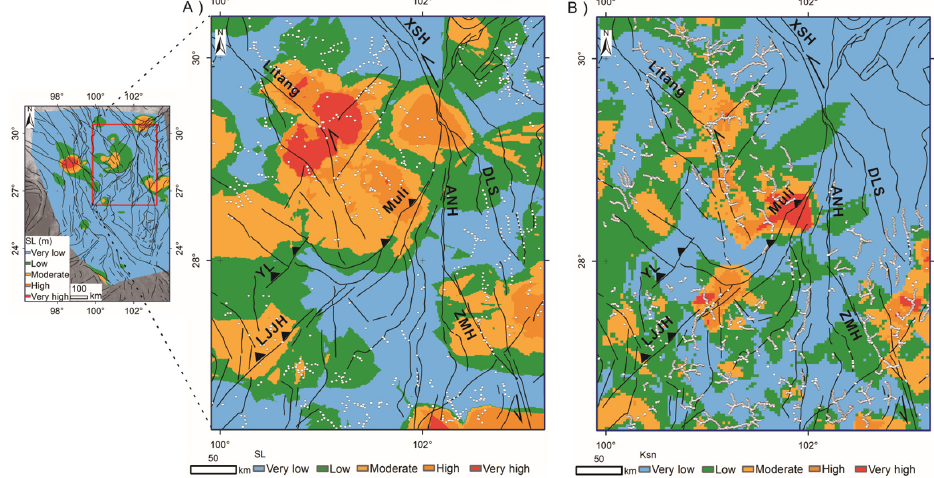
Figure 11. ( A ) Interpolation of SL points underlain by sandstone. The colors represent the following values: Blue—very low (44–181 m), green—low (181–288 m), yellow—moderate (288–407 m), orange—high (407–581 m), and red—very high (>581 m). ( B ) Interpolation of K sn points underlain by sandstone. The colors represent the following values: Blue—very low (8–427), green—low (427–847), yellow—moderate (847–1546), orange—high (1546–2833), and red—very high (>2833). White dots are SL/Ksn points within the sandstone. The range of B)/C) is indicated by a red rectangle in the inset map.